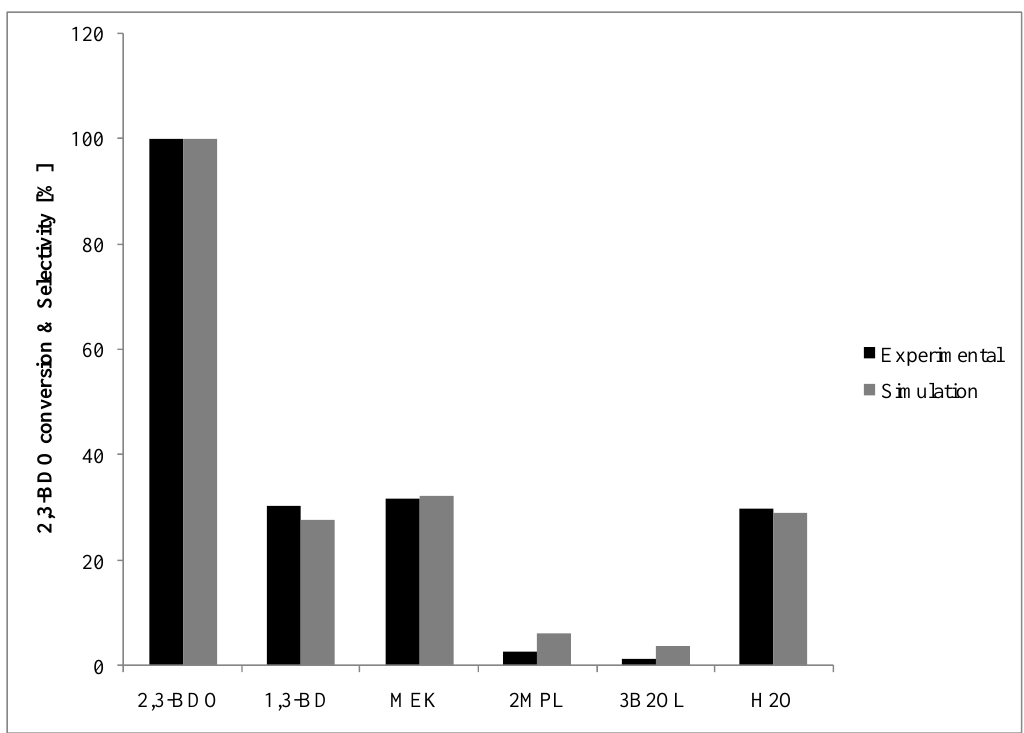
Figure 1. Comparison of the fluid temperature profiles of simulated and experimental data.